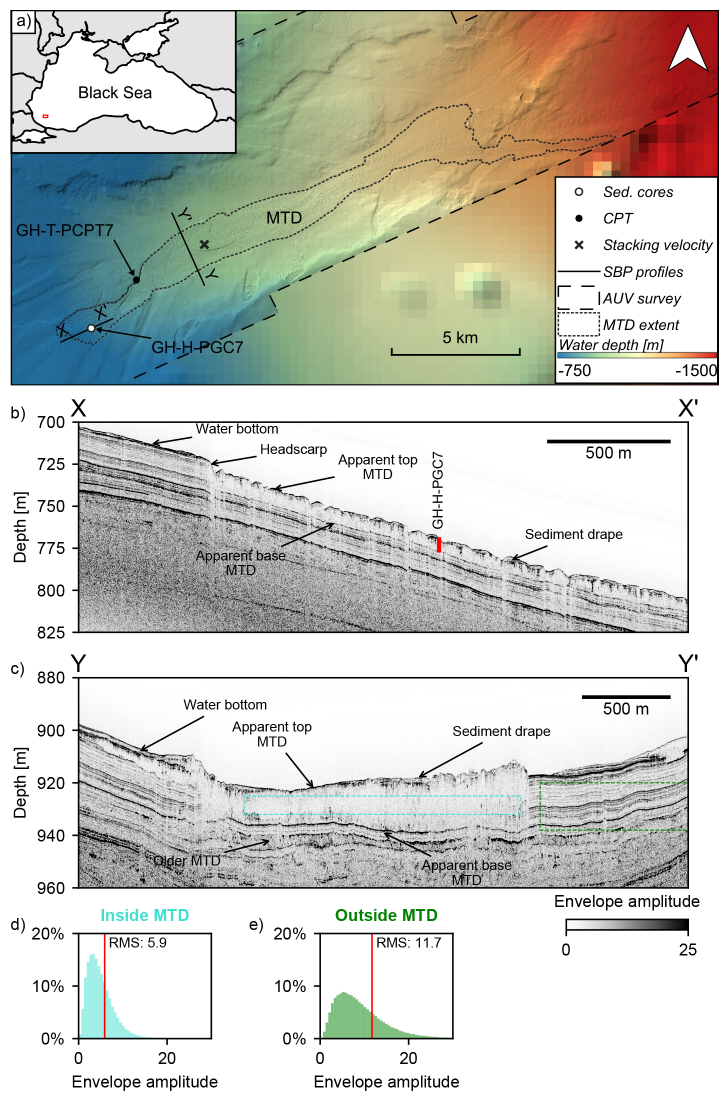
Figure 1. Example from the 2017 Black Sea geohazard survey of a mass-transport deposit (MTD) where the internal seismic amplitude response is appreciably lower compared to the unfailed sediments (acoustic transparency). (a) Map showing location of the sub-bottom profiles (SBPs), sediment core, CPT measurement and stacking velocity profile relative to the interpreted extent of the MTD. Background bathymetry from GEBCO Compilation Group (2021). (b) Downslope-oriented and (c) along-slope-oriented AUV SBPs intersecting the deposit. (d, e) Amplitude analysis